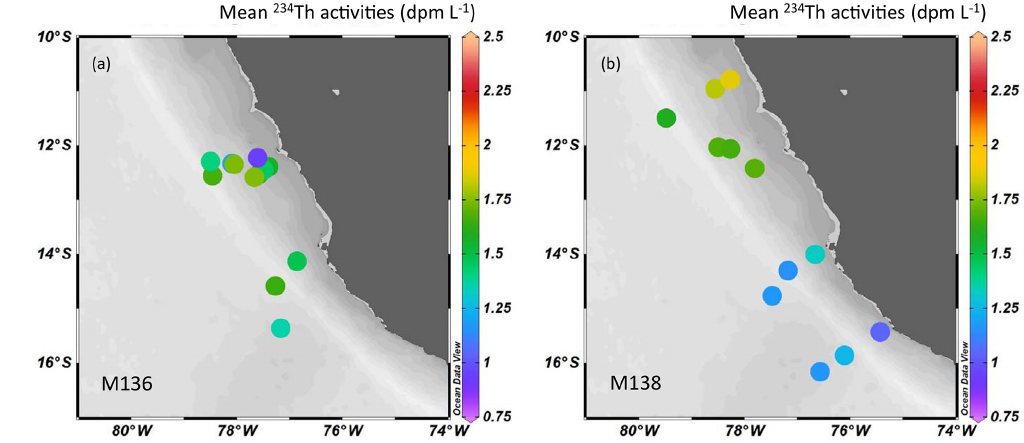
Figure 4. Distributions of averaged 234 Th activities during M136 ( a , top 30m) and M138 ( b , top